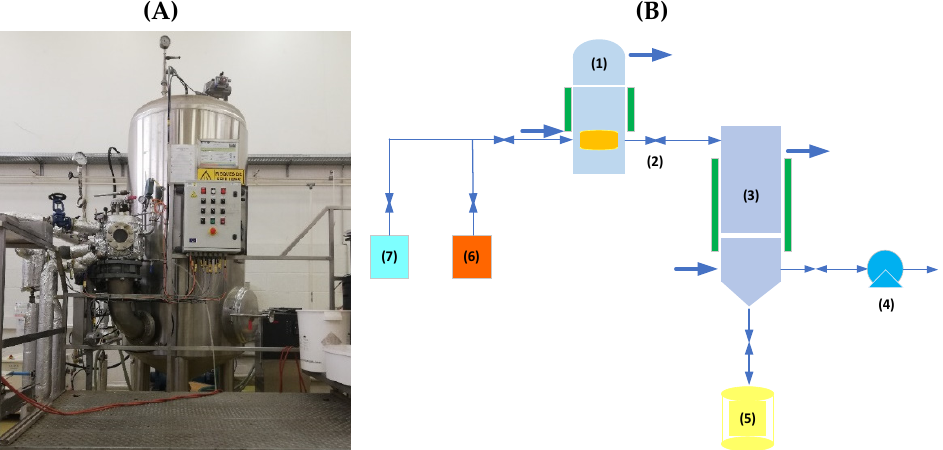
Figure 3. ( A ) Picture of the DIC MP reactor. ( B ) Schematic representation of a typical DIC reactor: (1) treatment vessel, (2) instant controlled pressure drop valve, (3) vacuum tank with cooling jacket, (4) vacuum pump, (5) extract collection trap, (6) steam generator, and (7) air